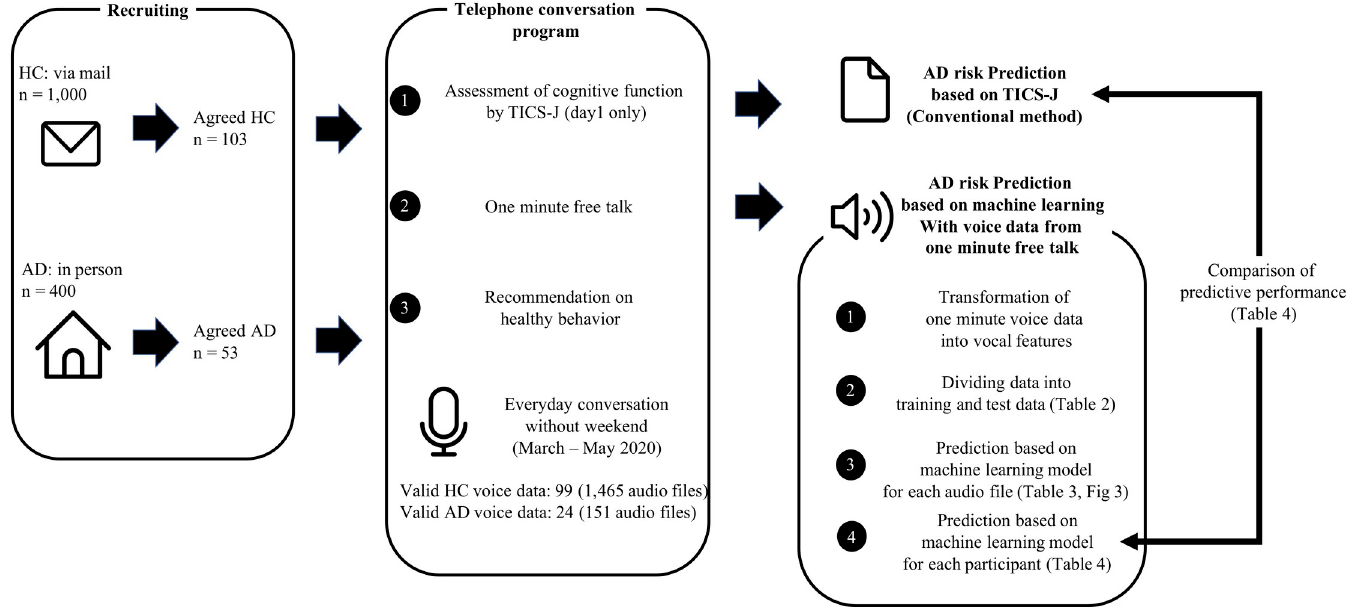
Fig 1. The whole process in the present